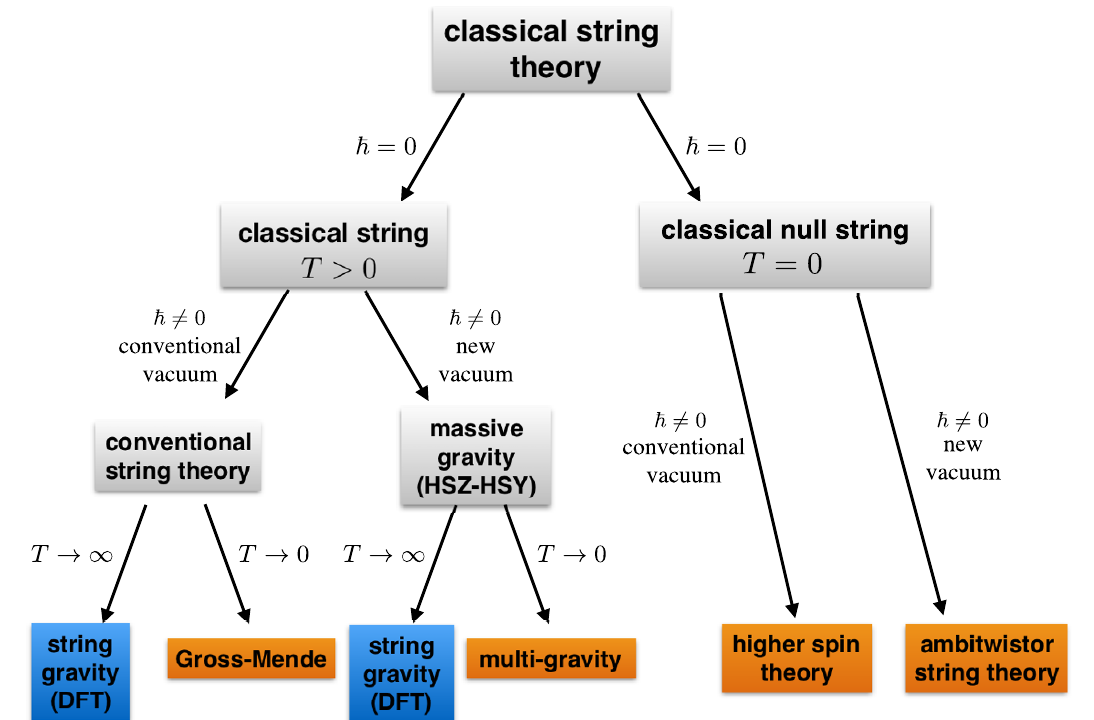
Figure 1 . Various limits of quantized closed string theory. Di(cid:11)erent limits correspond to di(cid:11)erent order of the (cid:12)rst-quantized worldsheet ~ and the string tension T = (2 (cid:25)(cid:11) 0 ) (cid:0) 1 (relative to a charac- teristic energy scale). It should be emphasized that ~ and T limits do not commute. Ambitwistor string di(cid:11)ers from multi-gravity, and a precise relation between higher spin theory and Gross-Mende high-energy scattering remains